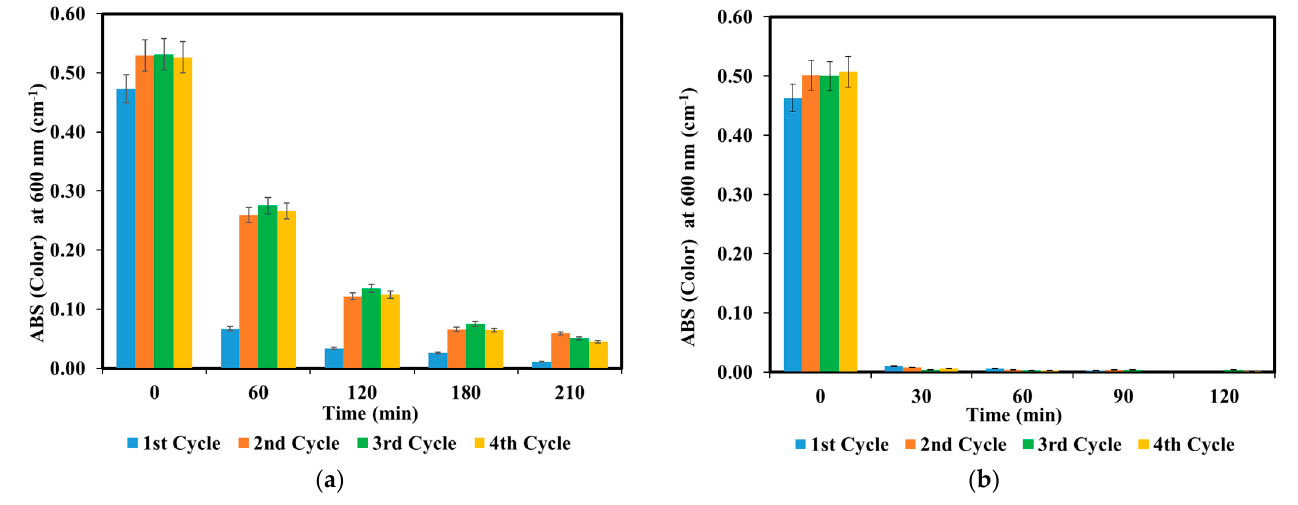
Figure 2. Changes in color (peak absorbance) values for LF/UV-A ( a ) and LF/PS/UV-A ( b ) treat- ments. Experimental conditions: RB5 = 20 mg/L; pH = 3; LF = 0.5 g/L; PS = 0.6 mM; I 0 = 0.5 W/L (UV-A); and t = 210 min for LF/UV-A and t = 120 min for LF/PS/UV-A treatment.